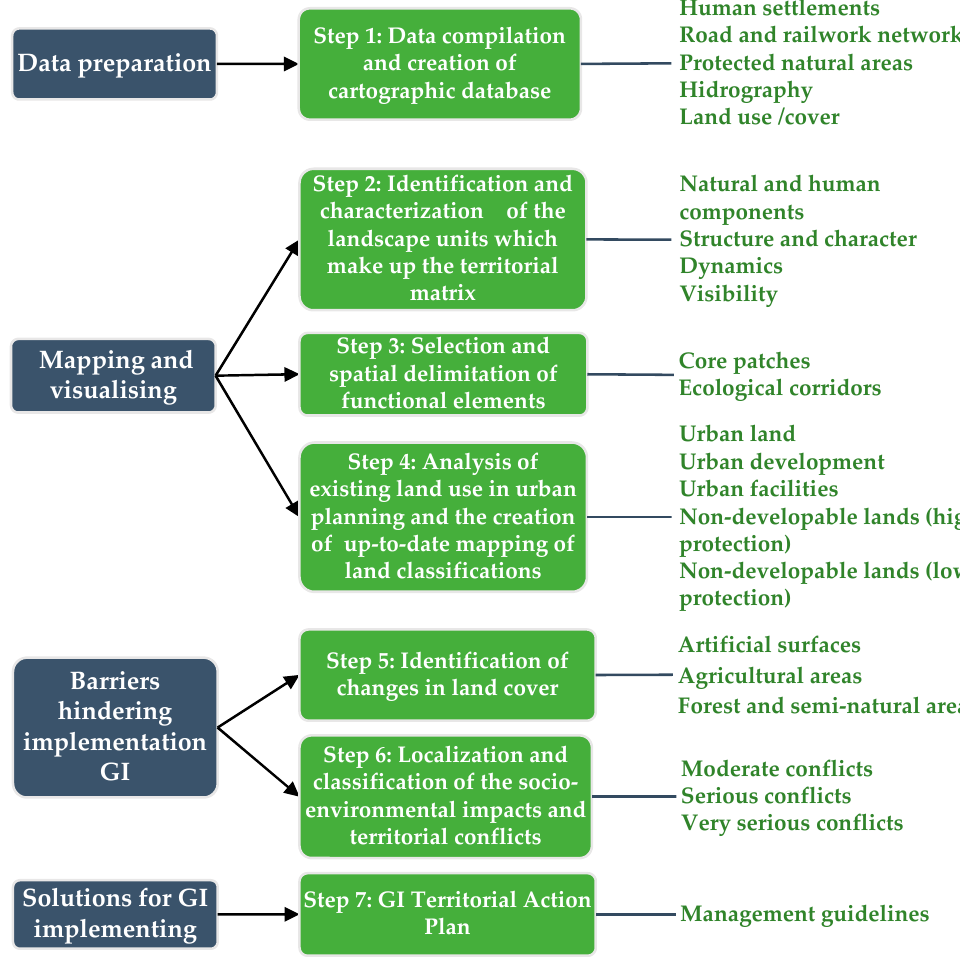
Figure 2. Methodology for Green Infrastructure planning based on landscape ecology approach. Step 1: Data compilation and creation of a database that is su ffi ciently detailed to be used at a supra-municipal